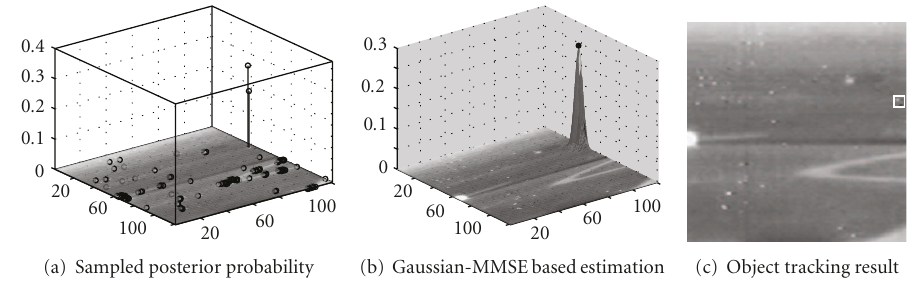
Figure 14: Tracking results for the NEH algorithm in a situation of strong ego-motion.